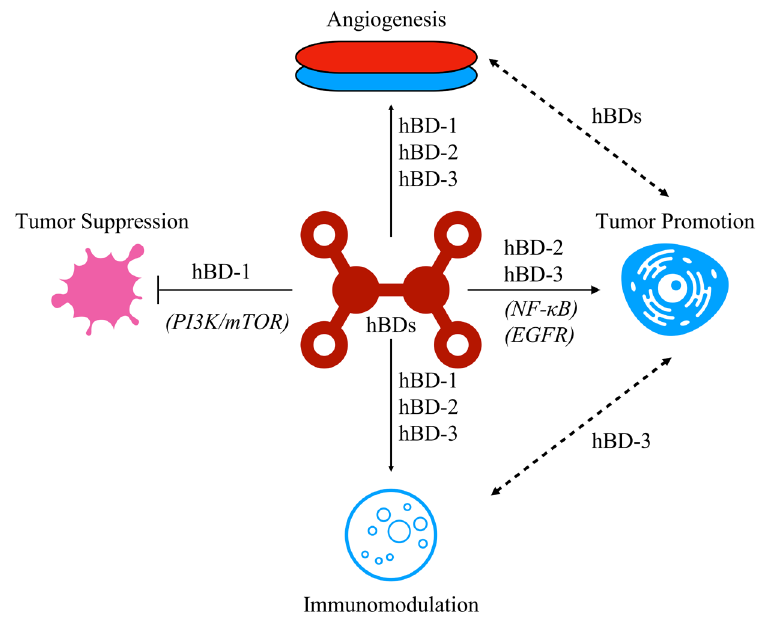
Figure 1. The multifunctional properties of human beta-defensins (hBDs) in regulating tumor growth and microenvironment. The diagram illustrates the conflicting roles of hBDs in cancer progression, and their context-dependent effects. The italicized text indicates possible pathways. Table 1. Summary of the clinical studies evaluating the hBD levels in head and neck cancer